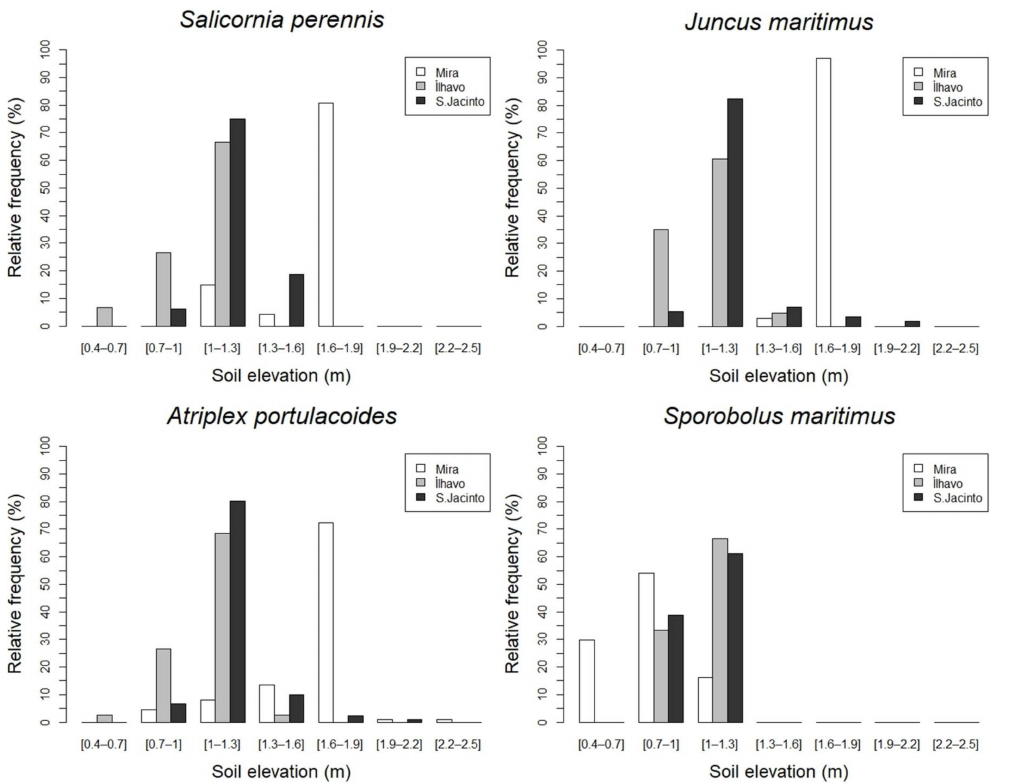
Figure 6. Relative frequency distribution of the main species over different soil elevation z(m) intervals for each studied salt marshes.